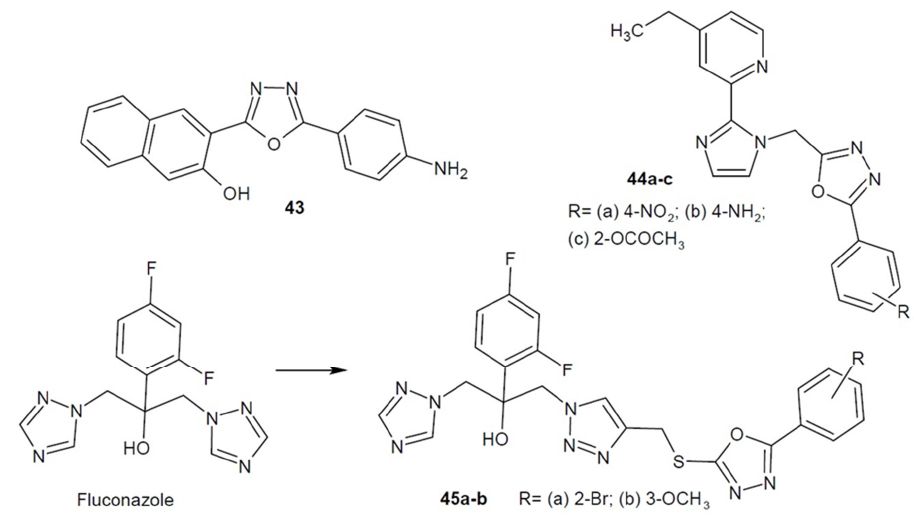
Figure 16. 1,3,4-oxadiazole derivatives with antifungal activity (part 1).